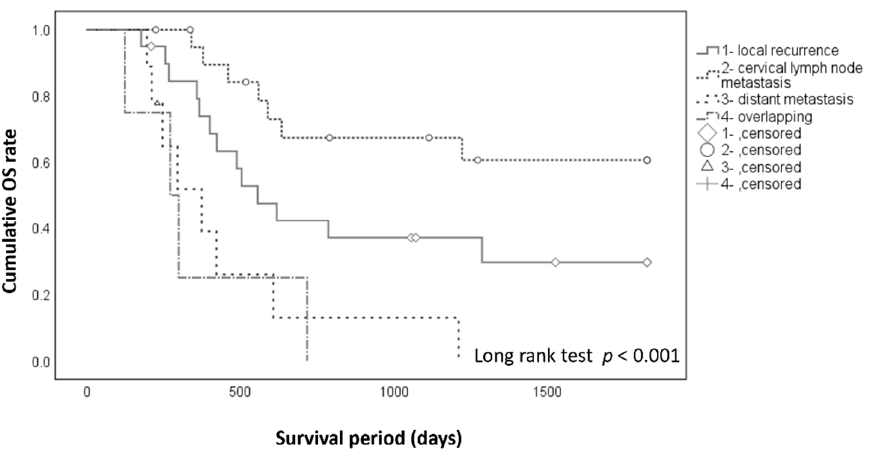
Figure 3. Cumulative overall survival (OS) after postsurgical events. The OS rate after occurrence of events was 29.6% for local recurrence alone, 60.6% for cervical lymph node metastasis alone, 0% for distant metastasis alone, and 0% in patients with two or more of these events ( p < 0.001).